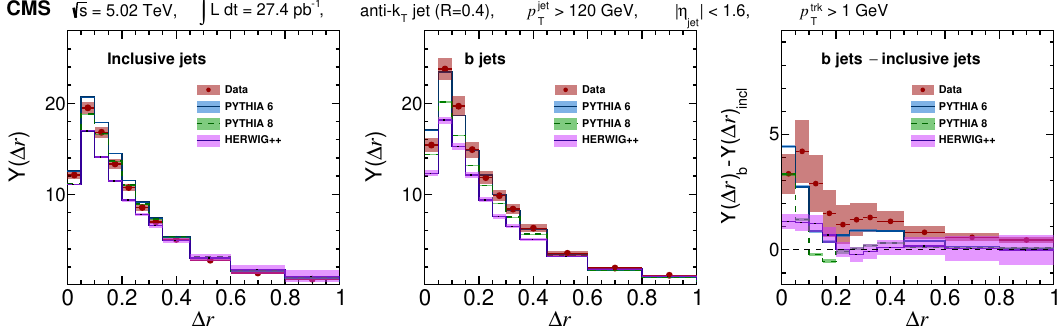
Figure 2 . Charged particle yield distributions Y (∆ r ) of inclusive jets (left) and b jets (middle) with 1 < p trk < 12 GeV are presented as functions of ∆ r . Both types of jets with p > 120 GeV T T and charged particles with 1 < p trk < 12 GeV are used to construct the distributions as functions T of ∆ r for data (red), pythia 6.426 (blue line), pythia 8.230 (green dashed line), and herwig++ (purple line) simulations. The right plot shows the particle yield difference of b jets and inclusive jets as functions of ∆ r for pp data, pythia 6.426 (blue line), pythia 8.230 (green dashed line) and herwig++ (purple line) simulations. The shadowed boxes represent the systematic